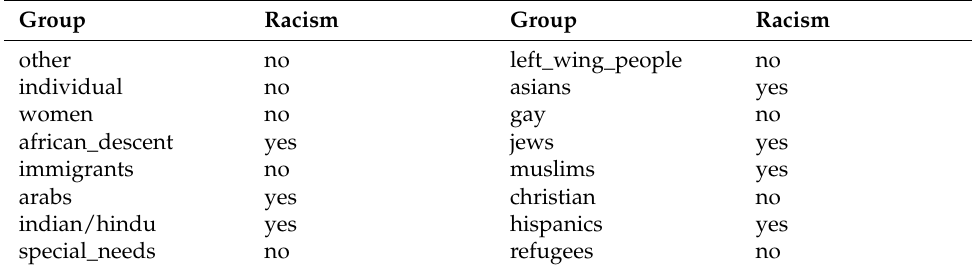
Table 3. Group labels used in the MLMA dataset.